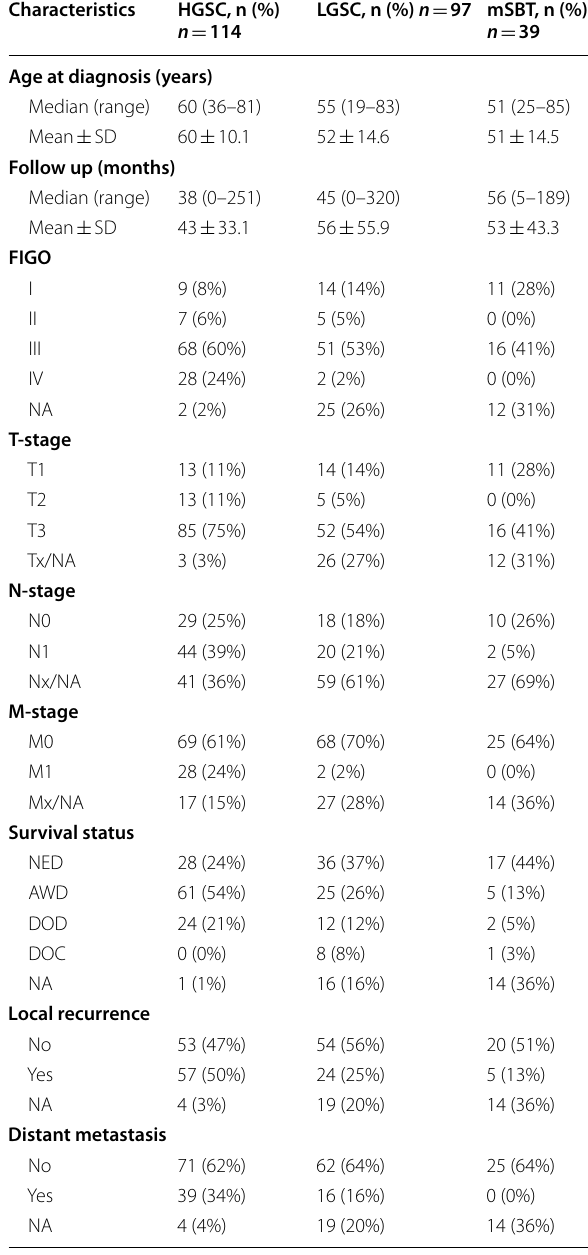
Table 1 Clinicopathological and survival characteristics of the dataset of 250 serous ovarian tumors